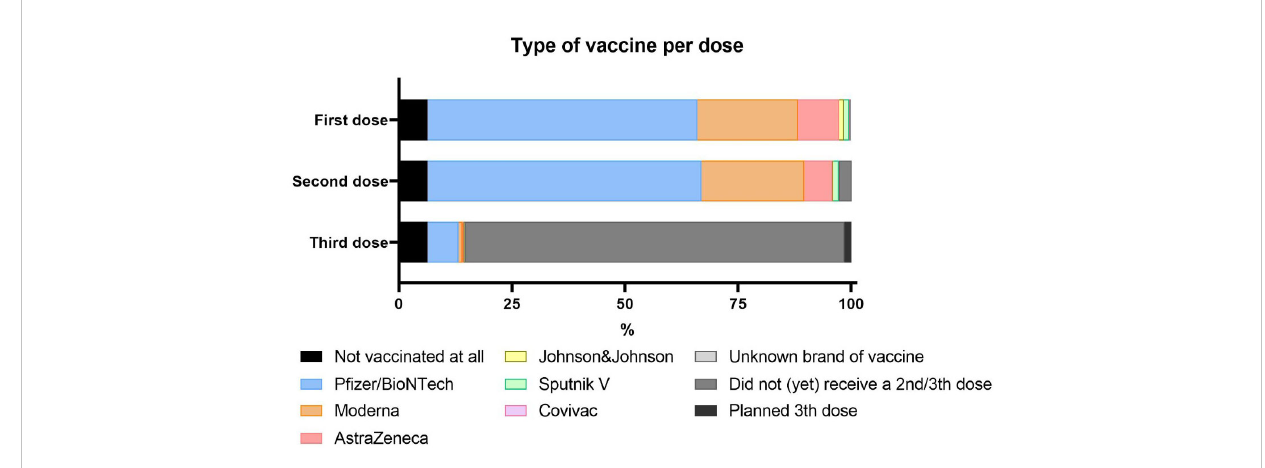
FIGURE 2 Type of COVID-19 vaccine per dose used in patients with PID that responded to the